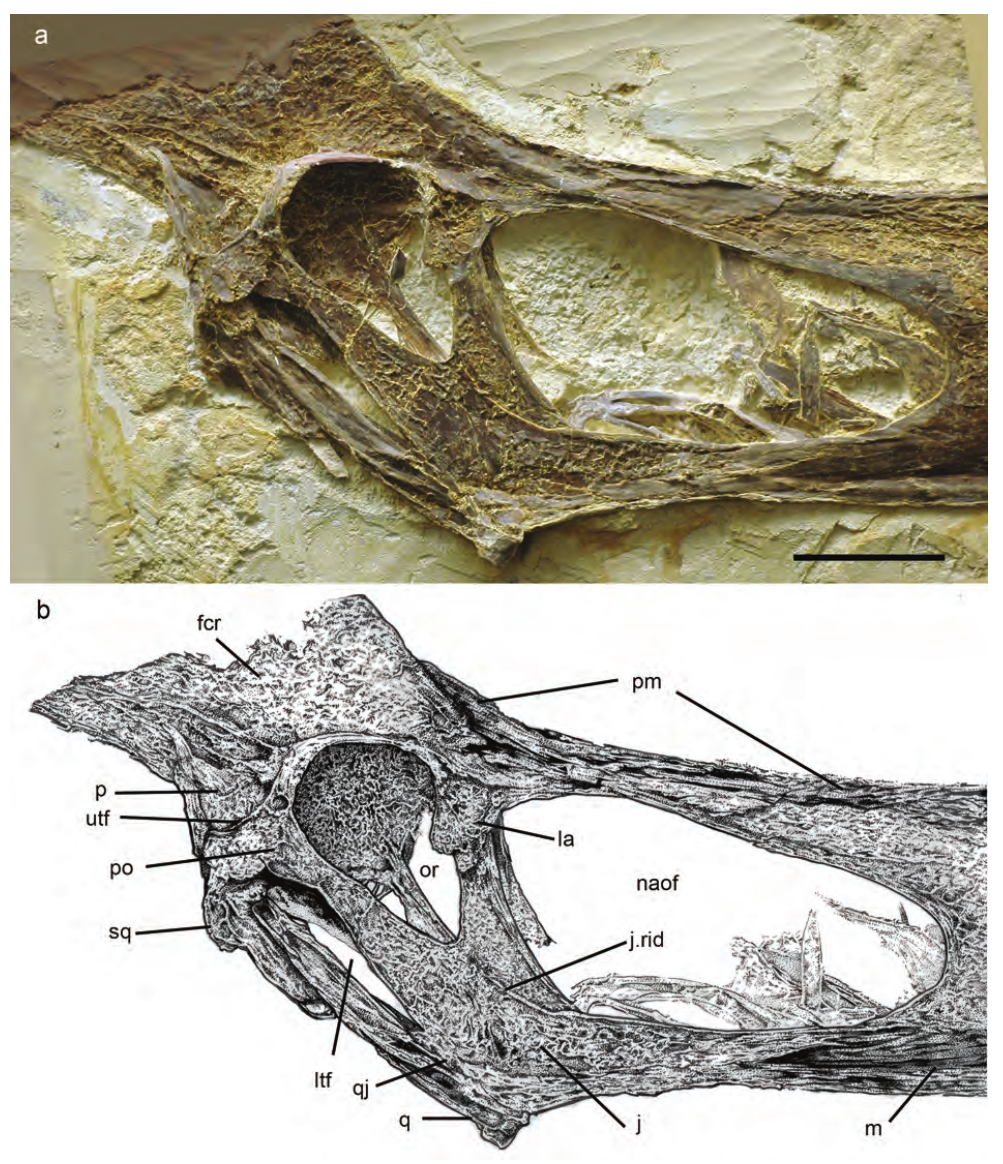
Fig. 3 – Dawndraco kanzai gen. et sp. nov., holotype (KUVP 27821), posterior region of the skull. (a) photograph and (b) drawing. Scale bar: 50